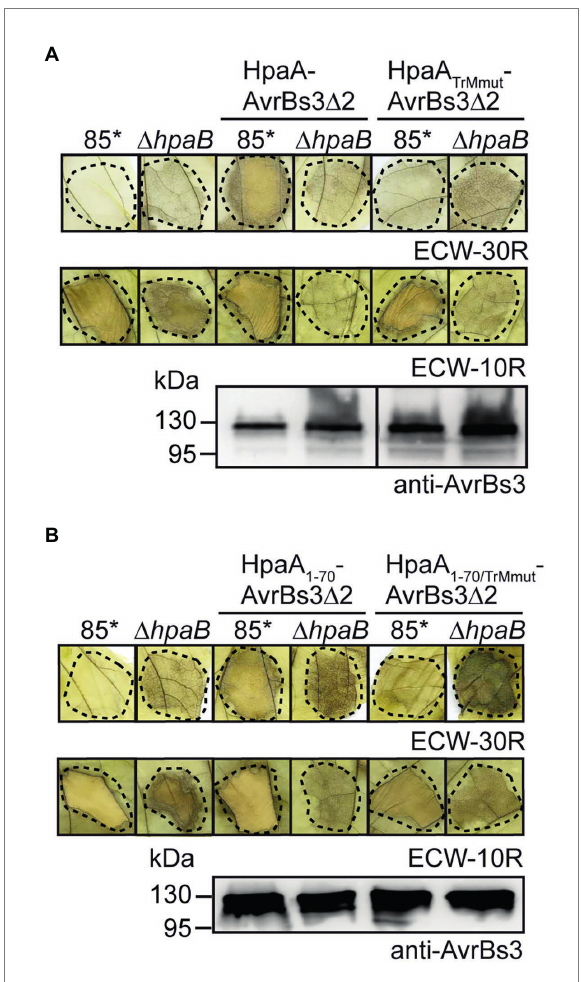
FIGURE 2 The N-terminal TrM determines HpaB-dependent translocation of HpaA. (A) The TrM is essential for HpaA translocation. X. euvesicatoria strains 85* and 85* ∆ hpaB with or without expression constructs encoding HpaA-AvrBs3 ∆ 2 or HpaA TrMmut - AvrBs3 ∆ 2 as indicated were infiltrated at a density of 4 × 10 8 cfu ml − 1 into leaves of AvrBs3-responsive ECW-30R and AvrBs1- responsive ECW-10R pepper plants. Leaves were bleached in ethanol 2 dpi. Dashed lines indicate the infiltrated areas. For protein analysis, bacteria were grown in NYG medium, and equal amounts of protein extracts were analysed by immunoblotting using an AvrBs3-specific antiserum. (B) Mutation of the TrM promotes translocation of HpaA in the absence of HpaB. X. euvesicatoria strains 85* and 85* ∆ hpaB with or without expression constructs encoding HpaA 1-70 -AvrBs3 ∆ 2 or HpaA 1-70/ TrMmut -AvrBs3 ∆ 2 as indicated were infiltrated into leaves of AvrBs3-responsive ECW-30R and AvrBs1-responsive ECW-10R pepper plants. HR reactions and protein synthesis were documented as described in (A)